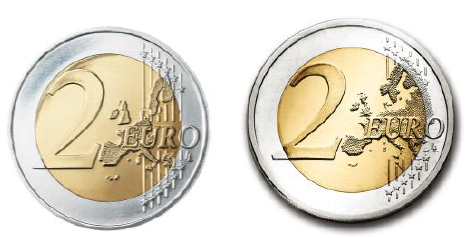
Figure 1. Common side of all two-Euro coins minted before 2007 (left) and minted from 2007 onwards (right).